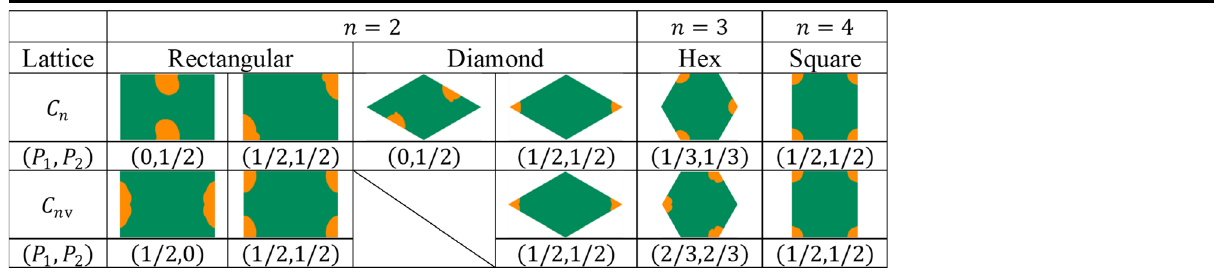
Figure A1: The flowchart for topology optimization of TCIs.